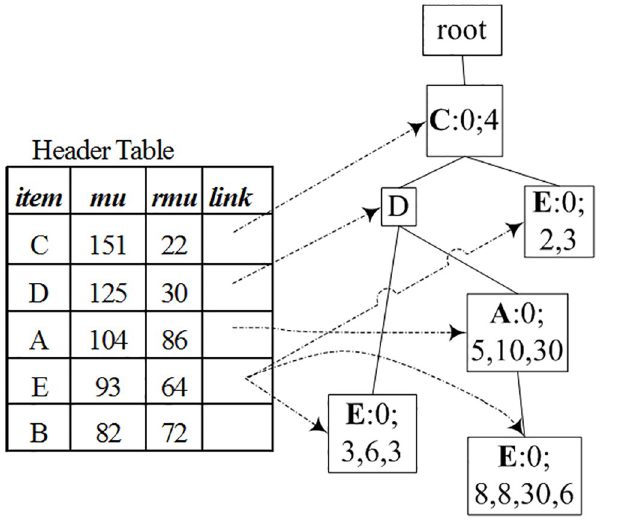
Fig 4. After removing node